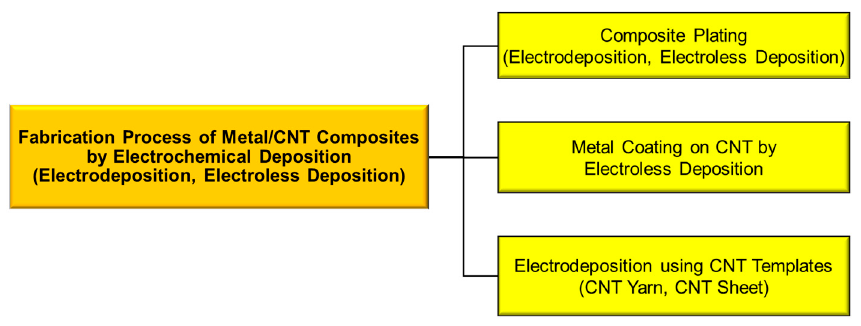
Figure 1. Classification of fabrication process for metal/CNT composites by electrochemical deposi- tion.